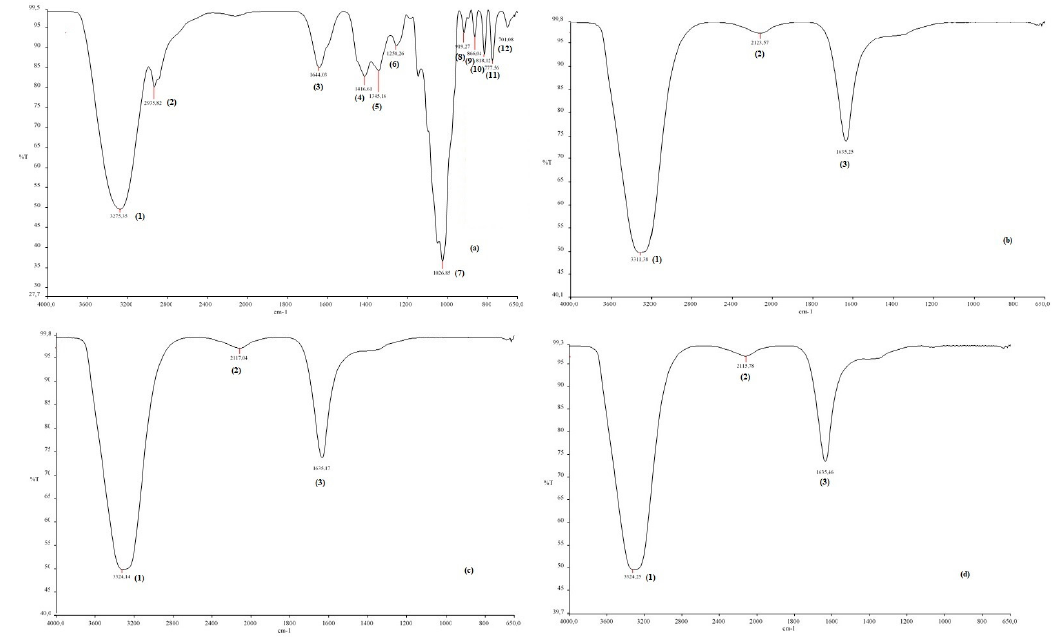
Figure 4. FTIR spectra of chestnut honey ( a ) and CH-AgNPs at 30 ( b ), 60 ( c ) and 90 °C) ( d ). Table 2. The list of FTIR peaks.